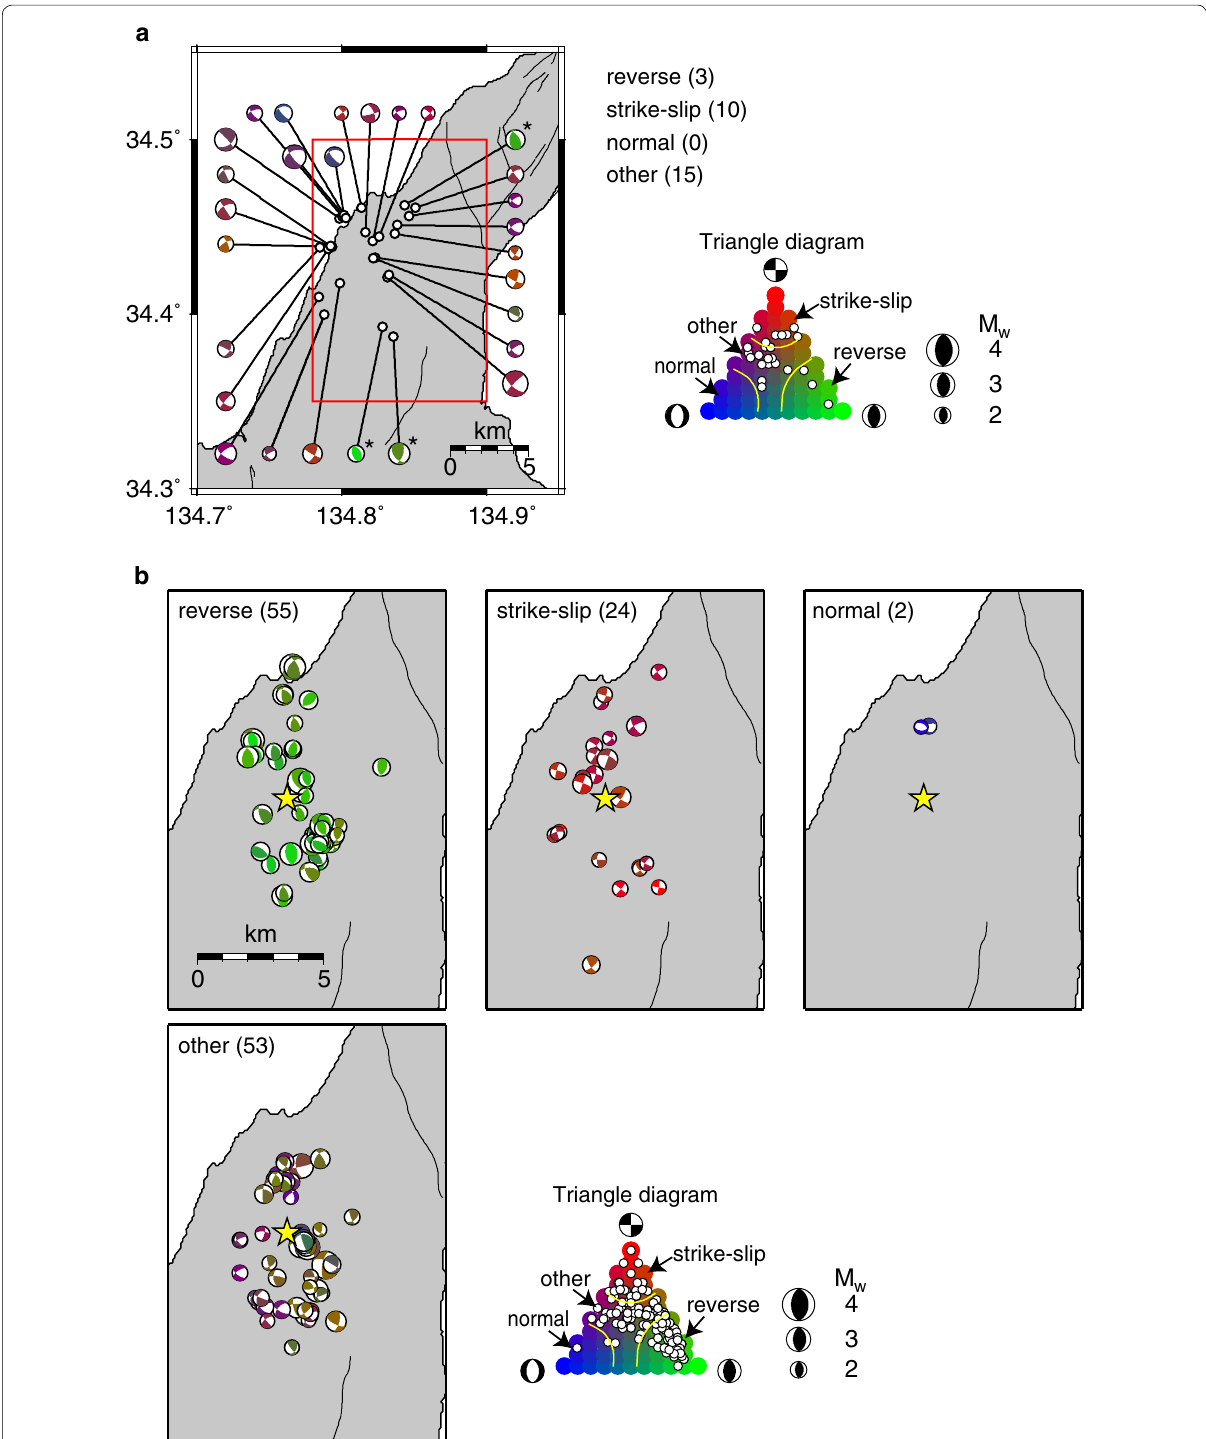
Fig. 5 Focal mechanism solutions determined in this study (lower hemisphere of equal-area projection). a Pre-shock focal mechanism solutions, where different colors are used to differentiate reverse (green), strike–slip (red), and normal (blue) faulting mechanisms. A triangle diagram (Frohlich 1992) with the color scale is presented in the right, where each focal mechanism is plotted by open circles. The number within each set of parentheses shows the number of events for that faulting mechanism. Beach balls with an asterisk in the upper right indicate a reverse-faulting earthquake. b Distribution of aftershock focal mechanisms for each faulting mechanism. The map area corresponds to the red rectangle in a . The hypoDD location of the mainshock is shown by a yellow